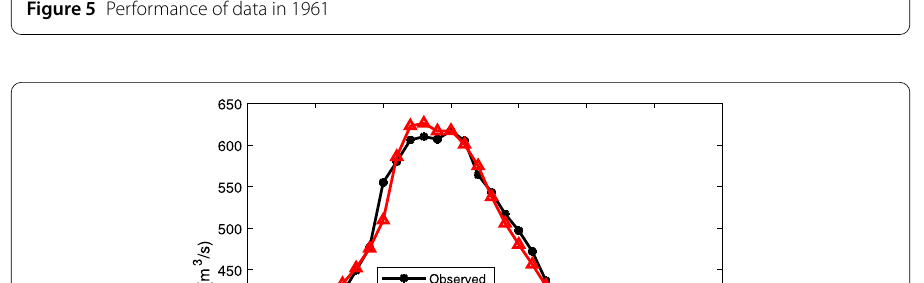
Figure 5 Performance of data in 1961